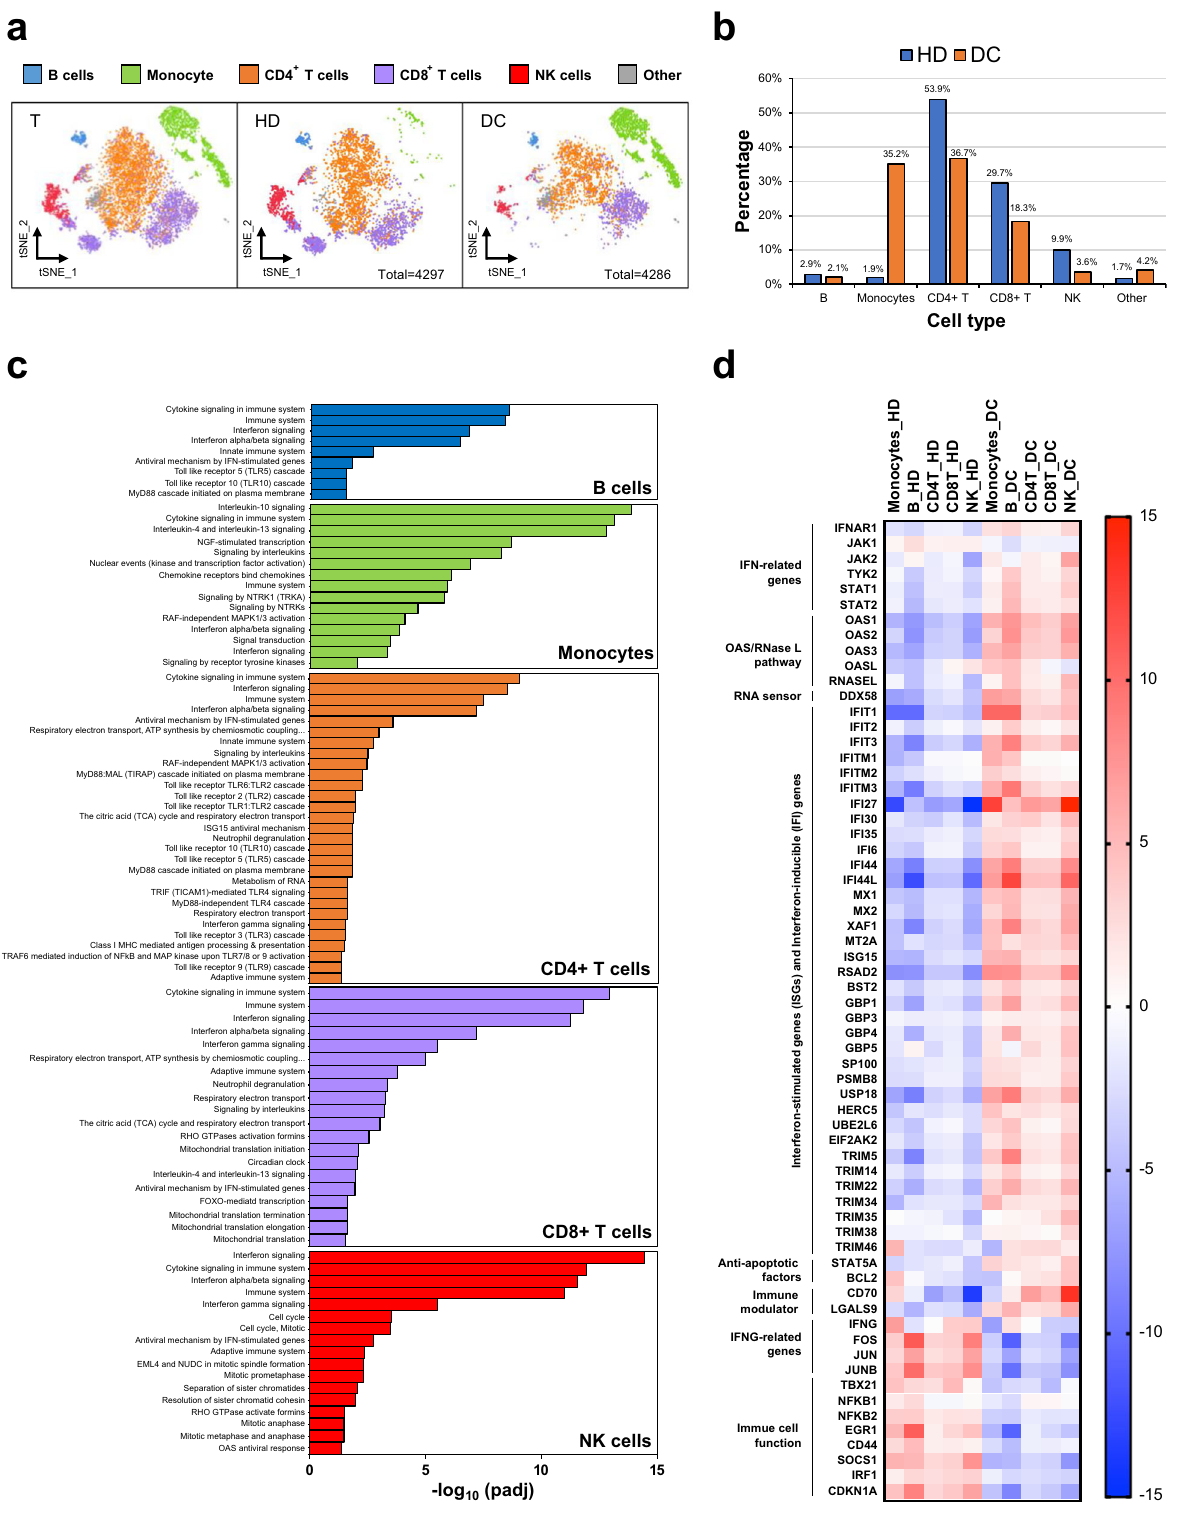
Fig. 2 Single-cell RNA-seq of PBMCs showing immunode fi ciency in the DC patient. a t-distributed stochastic neighbour embedding (tSNE) analysis of PBMCs from the healthy donor (HD) and DC patient. A total of 4297 and 4286 single cells for the HD and DC subjects were clustered into fi ve major clusters (B cells, CD4 + T cells, CD8 + T cells, monocytes, and NK cells). Cells were annotated by independently correlating each cell with reference transcriptomic datasets. T, Totality of cells analysed; HD, healthy donor; DC, DC patient. b Bar graph showing the percentage of each cell type relative to the total cell numbers in the healthy donor or DC patient. c Enriched pathways in the DC patient by Reactome analysis in each immune cell subset. d Heatmap of anti-pathogen response genes in immune cells for the healthy donor and DC patient coloured by average fold